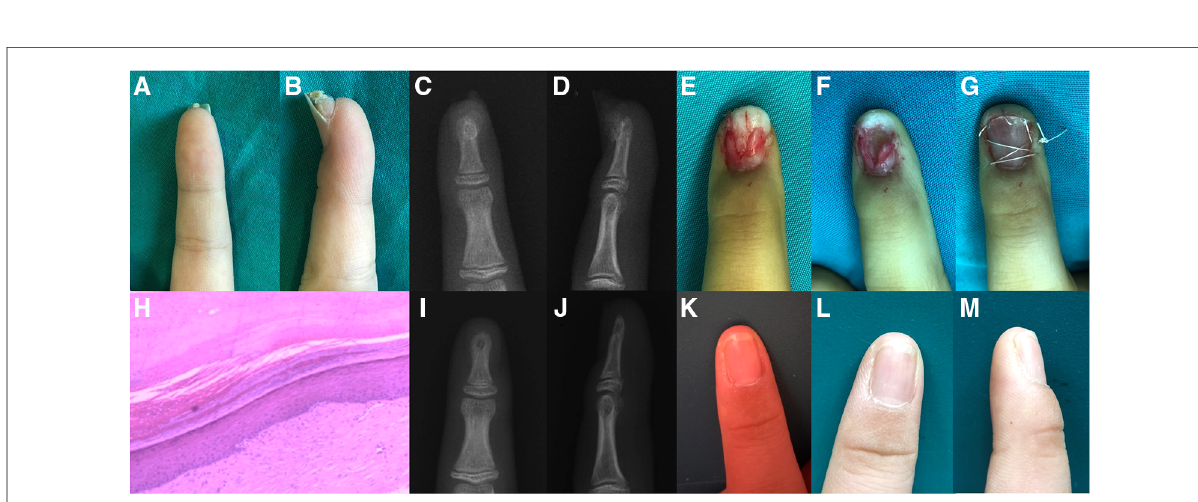
FIGURE 2 Subungual exostosis of the fi nger in an 8-year-old girl. ( A,B ) Physical examination revealed a fi rm, protuberant lesion of 0.8× 0.5 cm under the right index fi nger. ( C,D ) Posteroanterior and lateral radiographs of the lesion. ( E ) The lesion invaded the nail bed. ( F ) The lesions were completely removed with suf fi cient margin. ( G ) Replantation of the fi ngernail was adopted. ( H ) Histopathological analysis (hematoxylin-eosin staining, ×40 magni fi cation) revealed normal trabecular bone and fi brocartilage were overgrown, these fi ndings were consistent with the diagnosis of subungual exostosis. ( I – M ) No recurrence was found on posteroanterior and lateral radiographs, and the appearance of the fi ngernail remained good during 15 months of follow-up. The patient ’ s parents provided written informed consent to publish the details of the patient ’ s